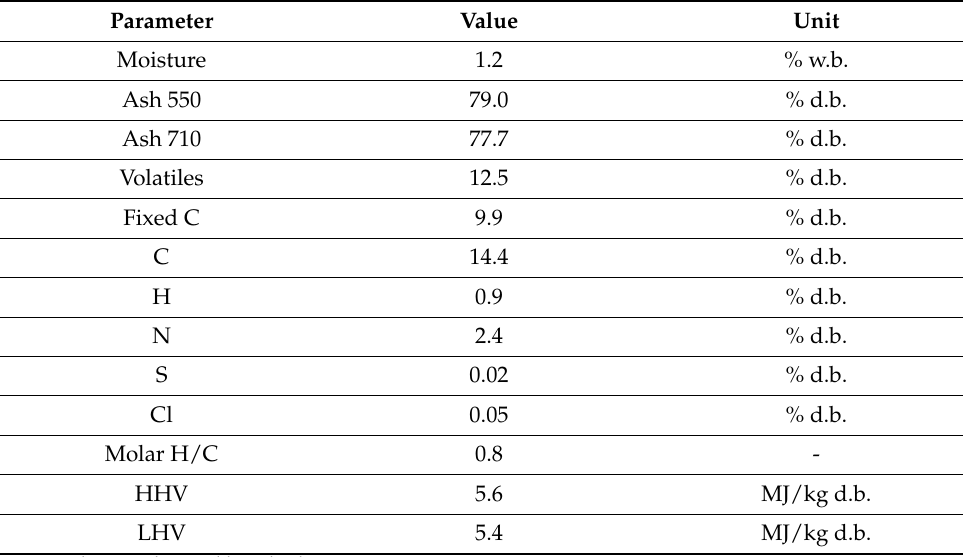
Table 10. Elemental composition of char (from SPYRO pilot plant). Element Value Unit Al 142,848 mg/kg d.b.